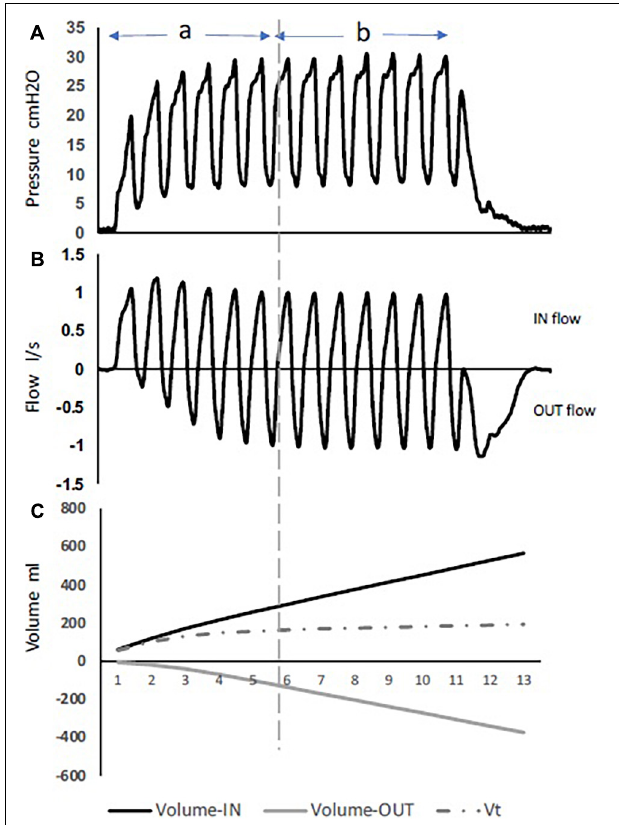
FIGURE 3 | Pressure, flow, and volumes during HFPV inspiratory interval, using a lung model. During phase (A) full flow acceleration with an increase in volume-in delivery, while phase (B) is characterized with more volume-out. (C) The difference between volume-in and volume-out is the tidal volume. Note the tidal volume value remains stable during the whole plateau